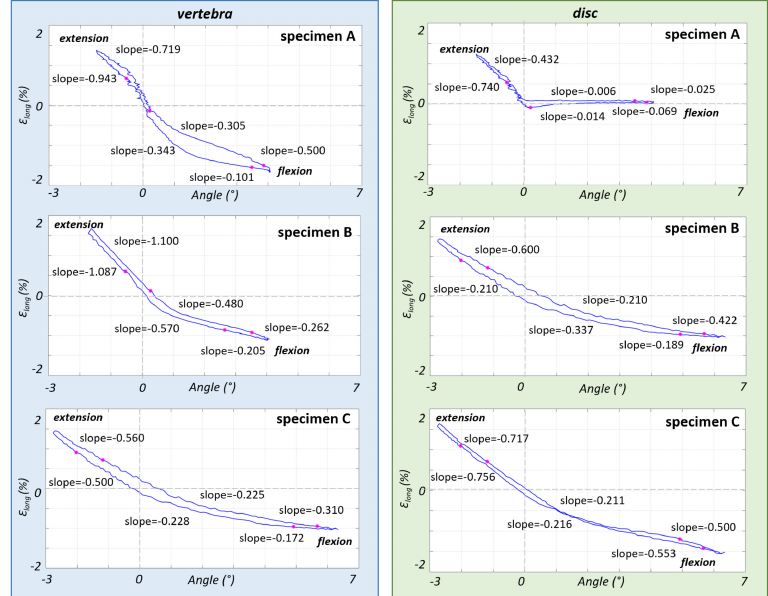
Figure 5. The strain-angle curves of the third loading cycle are reported for each specimen, showing how the strain in the ALL varied in front of the vertebra (left charts) and in front of the disc (right charts) for specimens A, B, C (from top to bottom). The end of the NZ and the beginning of the EZ (identified on moment-angle curves, Figure 2), are reported here with circles. The values of minimum and maximum slope (% strain / ◦ degree) for the NZ and EZ are reported for both of the curves flexion-to-extension and